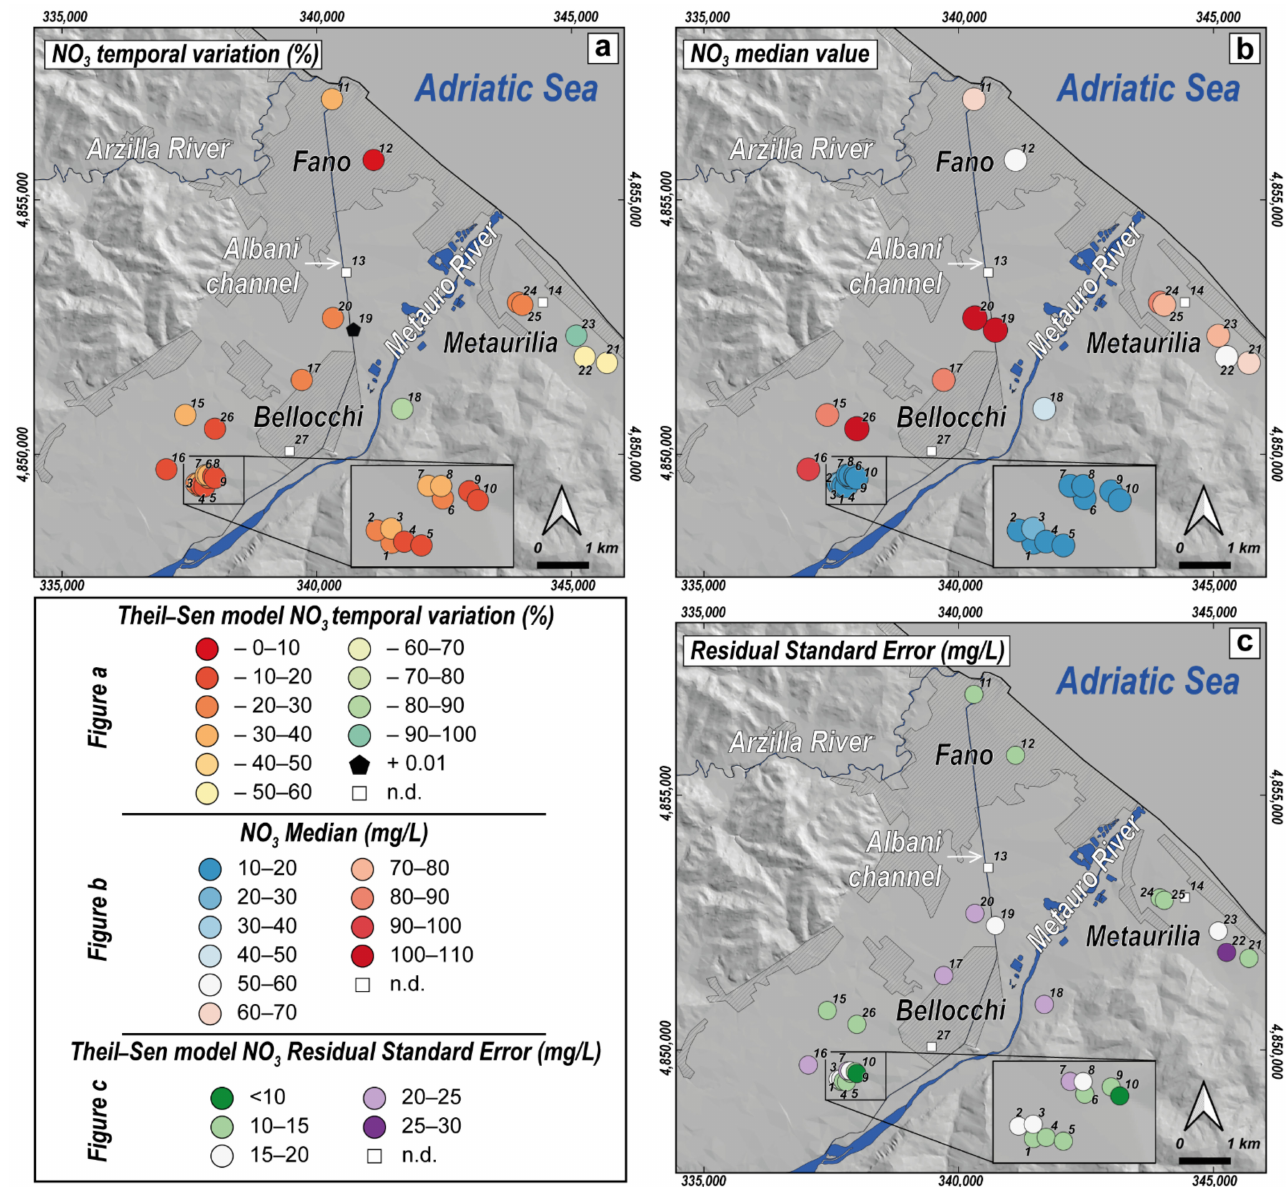
Figure 10. ( a ) Temporal variations in NO 3 − concentrations (in %) defined by the Theil-Sen model; ( b ) NO 3 − median values (in mg/L); ( c ) Residual Standard Error (in mg/L) defined by the Theil-Sen model. All the maps are referred to data belonging to the 2009–2020